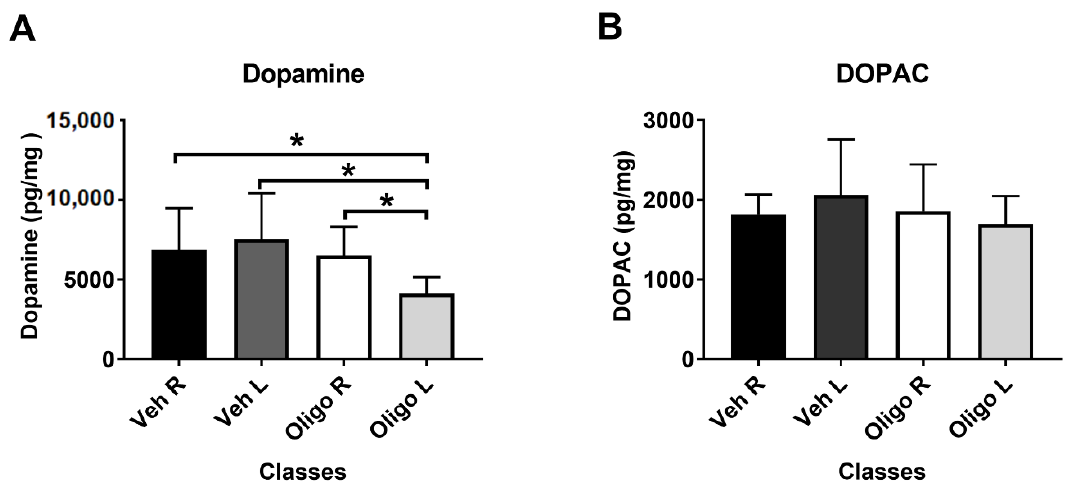
Figure 1. Striatal content of dopamine (DA) ( A ) and 3,4-Dihydroxyphenylacetic acid (DOPAC) ( B ). DA and DOPAC levels (pg/mg fresh tissue) were measured in the left (L) and right ® striata of rats infused with human α-synuclein oligomers (HαSynOs) or vehicle, three months after inoculation. Data are expressed as the mean and the standard deviation for each class. * p < 0.05).